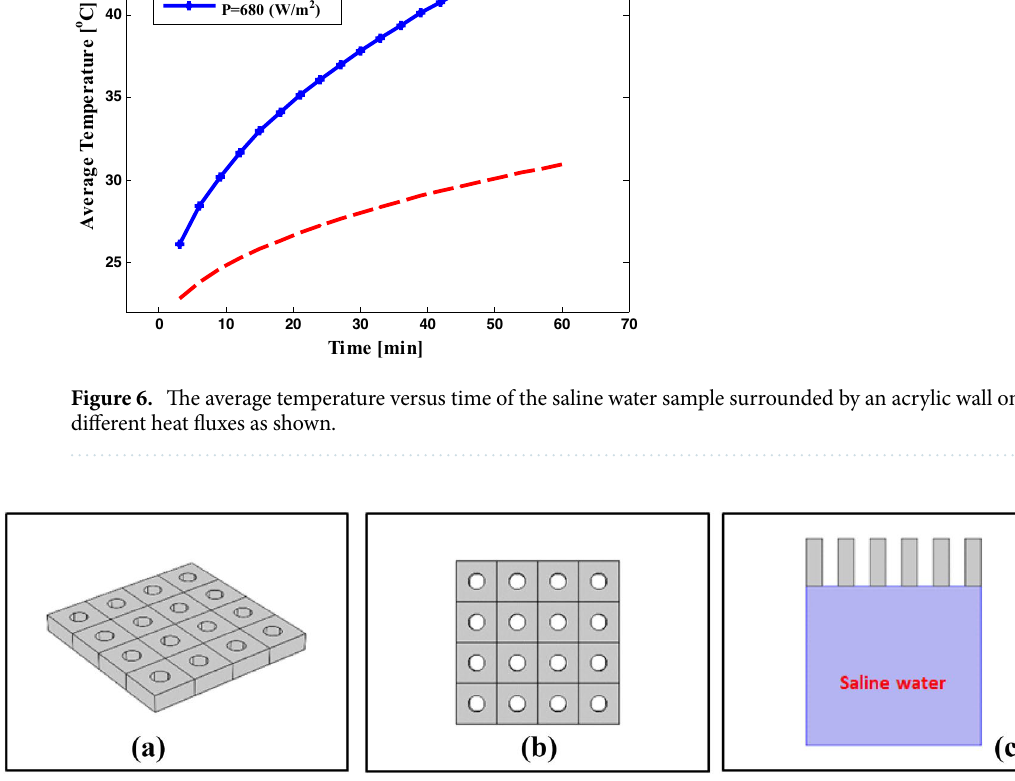
Figure 7. Schematic structure of 2D-PCs that act as a solar umbrella that floats on the saline water surface, ( a ) 3D structure, ( b ) upper view, and ( c ) side view with saline water as